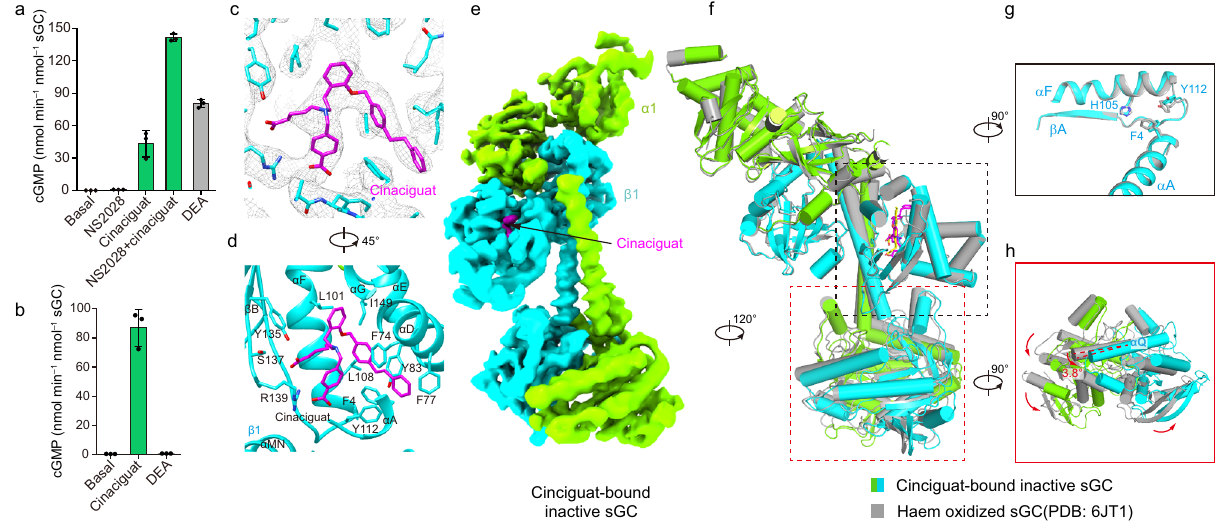
Fig. 3 Structure of sGC in the cinaciguat-bound inactive state. a End-point activity assay of the wild-type sGC samples in the presence or absence of 20 mM NS2028, 20 mM cinaciguat or 100 mM DEA. NS2028 oxidizes the ferrous haem in sGC to ferric haem. Mean± s.d., n = 3 biologically independent reactions. Source data are provided as a Source Data fi le. b End-point activity assay of the haem-free sGC samples with or without 20 mM cinaciguat or 100 mM DEA as indicated. Mean± s.d., n = 3 biologically independent reactions. Source data are provided as a Source Data fi le. c Density at the cinaciguat binding pocket in the CI state. Cinaciguat is shown as magenta sticks. d The interactions between cinaciguat and sGC in the CI state. A 45° rotated view compared to ( c ). e Cryo-EM map of sGC in the cinaciguat bound inactive (CI) state. The density of cinaciguat is shown in magenta. f Structural comparison of sGC in the CI state (colored) and haem-oxidized state (gray) by aligning the β 1 H-NOX domain. g A 90° rotated zoom-in view of the β 1 H-NOX domain boxed in f (black rectangle). The side chains of H105, Y112, and F4 are shown as sticks. h A 90° rotated view of catalytic module boxed in f (red rectangle). The angle between the α Q helices is